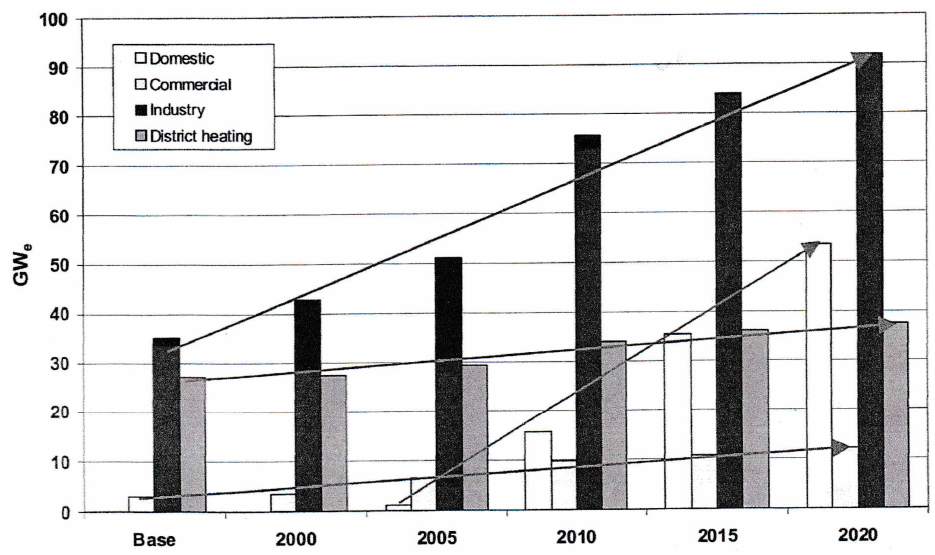
Figure 10. Cogeneration use in different sectors [30].